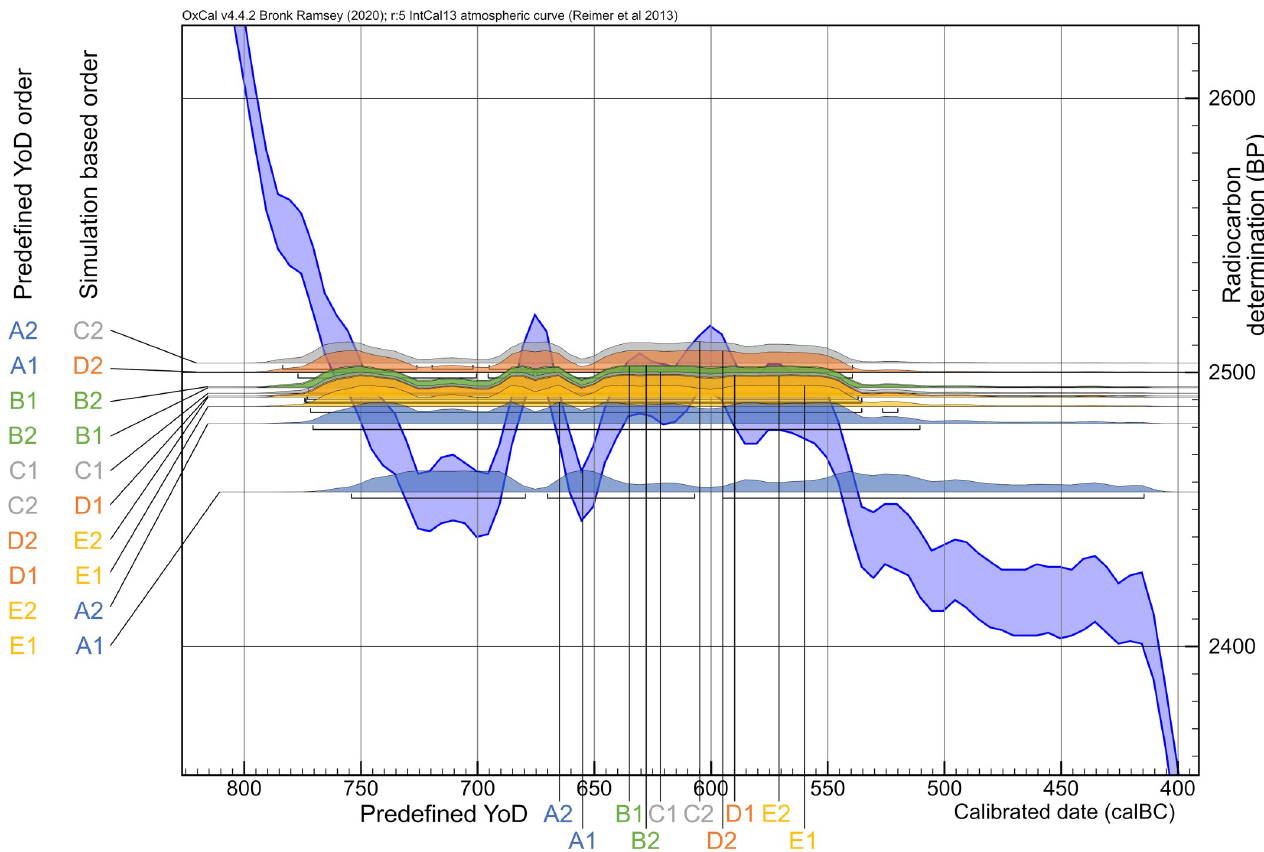
Fig 12. Closeup of calibrated radiocarbon dates of the plateau model. Unmodelled 14 C ages with 25 years uncertainty on the Hallstatt plateau section (cf. Fig 4A) of the calibration curve (IntCal13) show the inversion of calibrated dates (2-sigma), especially individual A1 (YoD = 655 BC), resulting in a much wider dating range and in the youngest placement regarding simulation-based